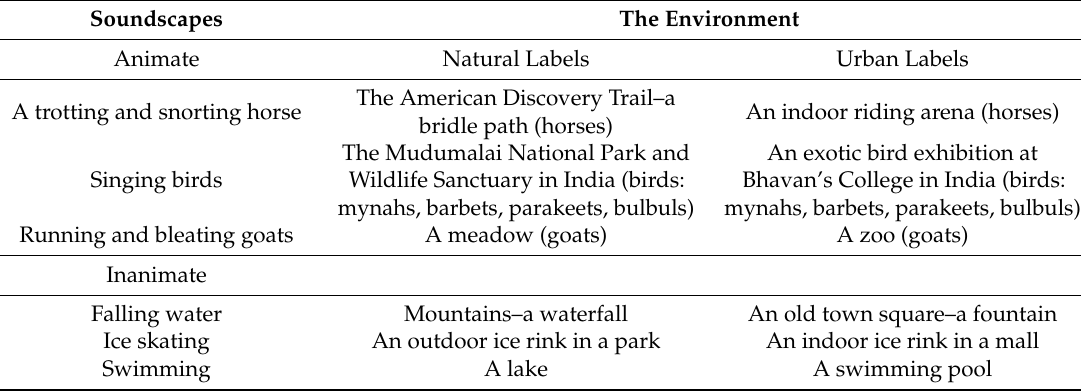
Table 1. Recordings and verbal labels used in the